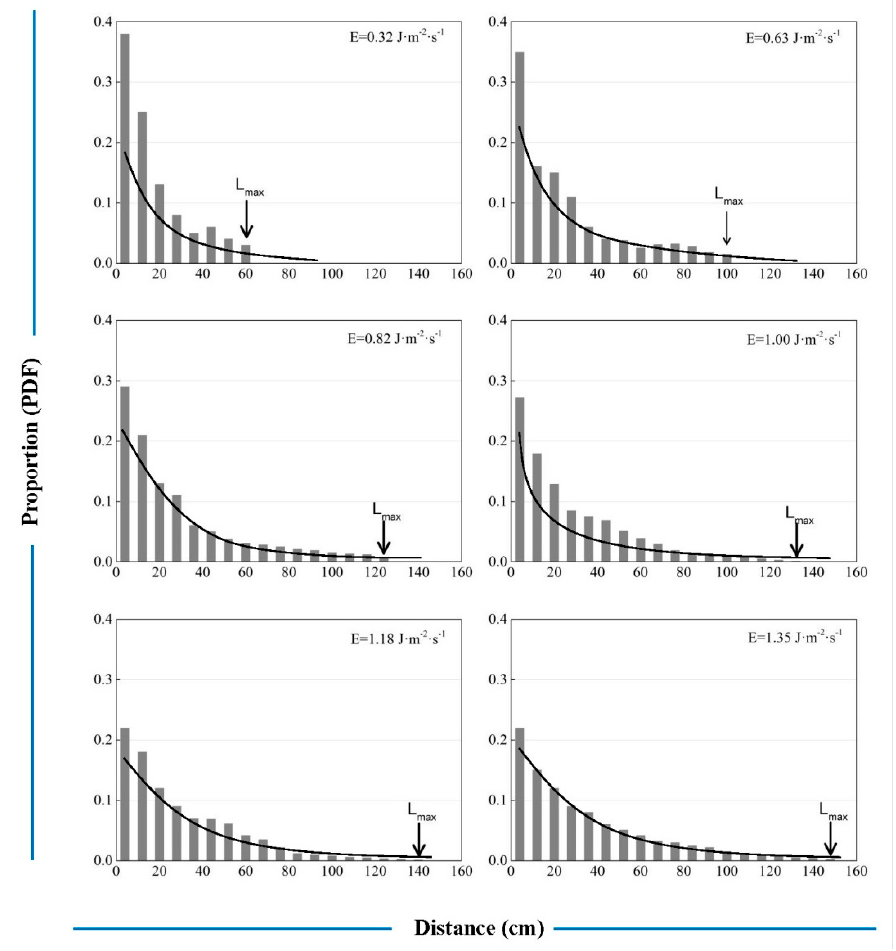
Figure 7. Splash downslope PDFs (I = 0.32, 0.63, 0.82, 1.00, 1.18 and 1.35 J · m − 2 · s − 1 ) (adapted from paper